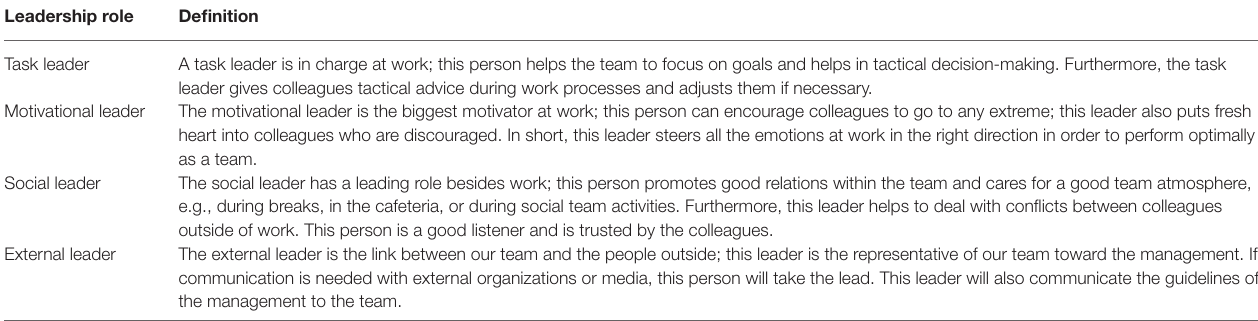
TABLE 2 | Definitions of the four leadership roles based on the work of Fransen et al. (2014), that were presented to the